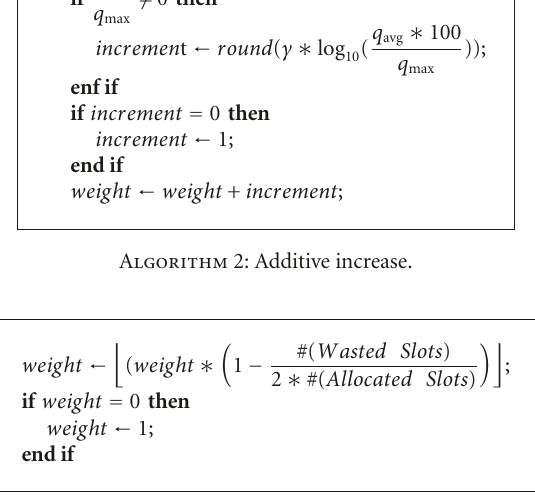
Algorithm 3: Multiplicative